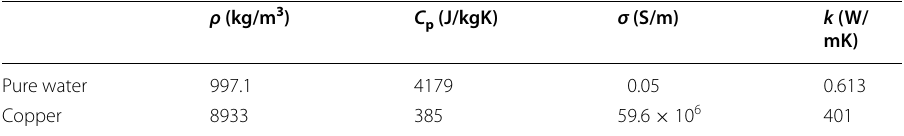
Table 1 Thermophysical properties of water and